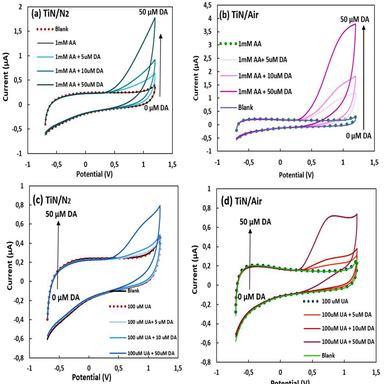
CV voltammograms of both TiN/N2 and TiN/Air electrodes in PBS solution (50 mM, pH = 7.4) containing various dopamine concentration in at presence of 1 mM ascorbic acid (a, b) and100μM uric acid (c, d) at scan rate of 50 mV/s.